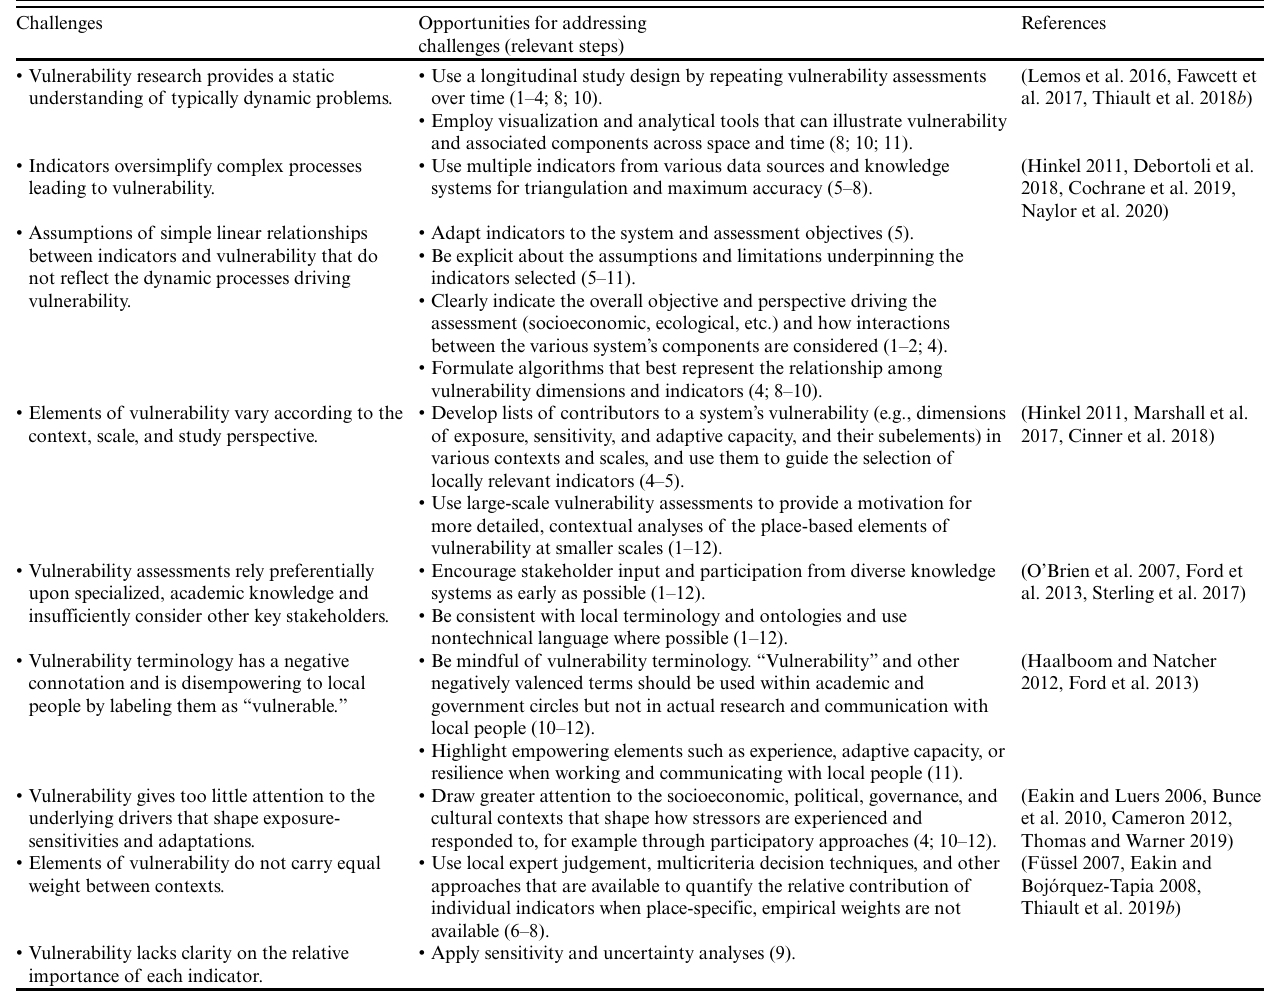
Table 2 . Challenges for considering vulnerability assessments in decision